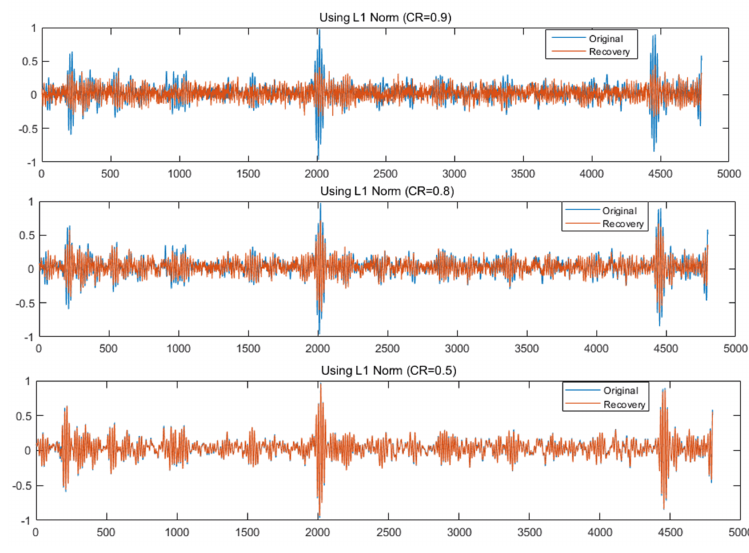
Figure 5. Reconstructed waveform of outer race fault.